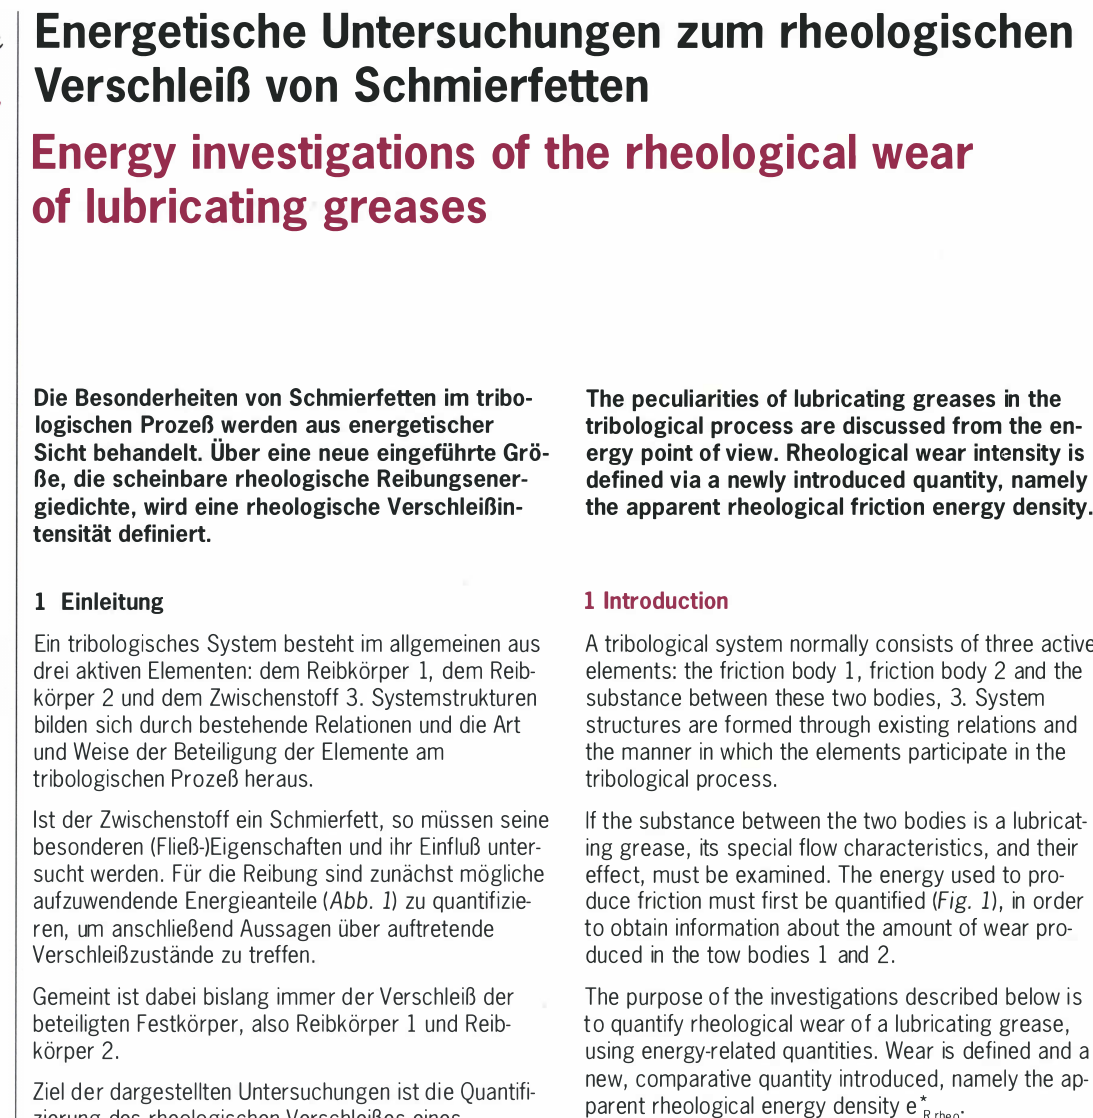
Fig. 1: Friction contents according to their double nature according to